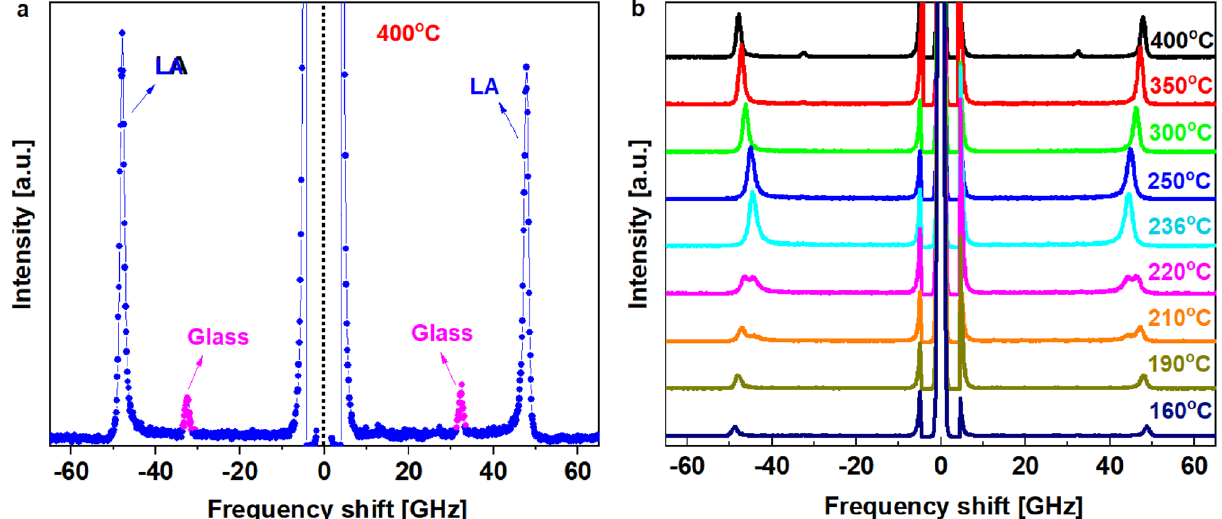
Figure 1. ( a ) Brillouin spectrum of PZO:Nb single crystal at 400 °C. The "Glass" denotes the LA mode coming from the glass substrate, which supports the thin PZO:Nb crystal; ( b ) Temperature dependence of the Brillouin spectrum for PZO:Nb. Splitting of the LA mode (LA1 and LA2 further in the text) is observed in the range 227–203 °C. In the ( b ) it is cleraly visible for temperatures 220 °C and 210